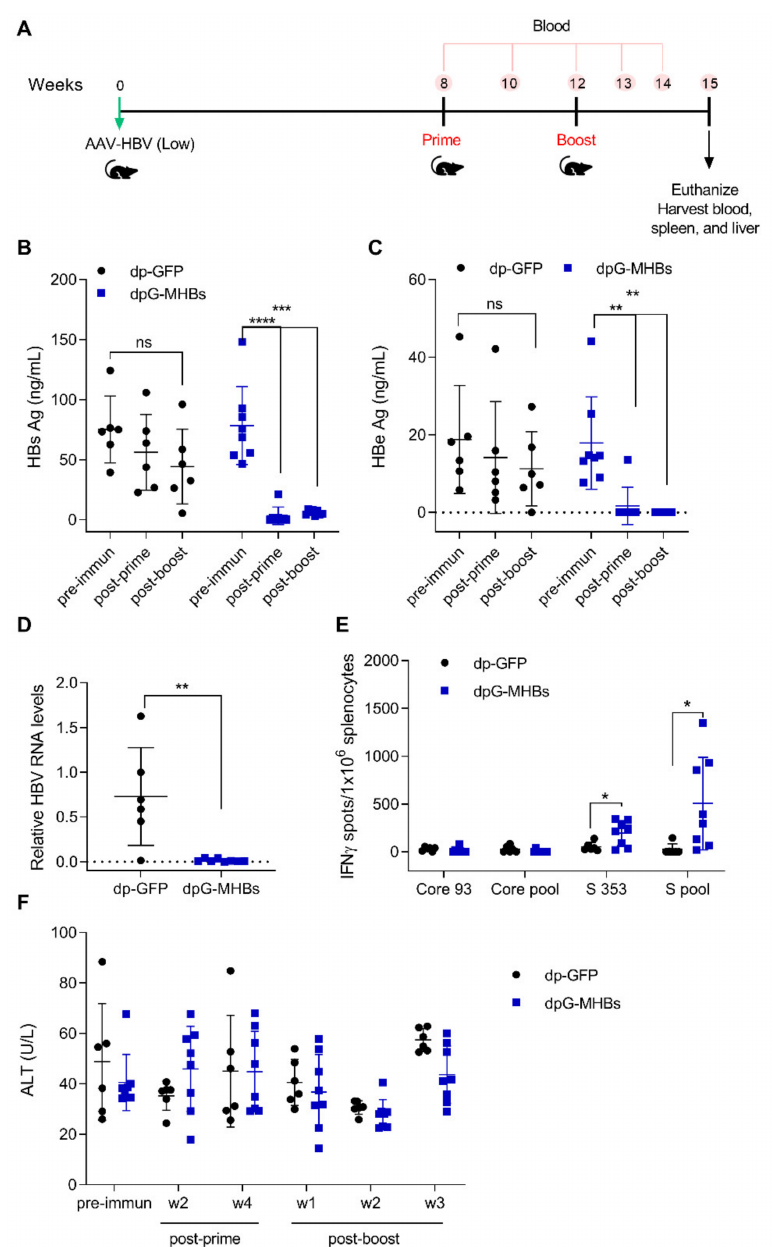
Figure 4. VLV dp immunization controls HBV replication in mice with pre-existing lower HBV antigen levels. ( A ) Mice were transduced with 3 × 10 10 genome copies of AAV-HBV and after HBV